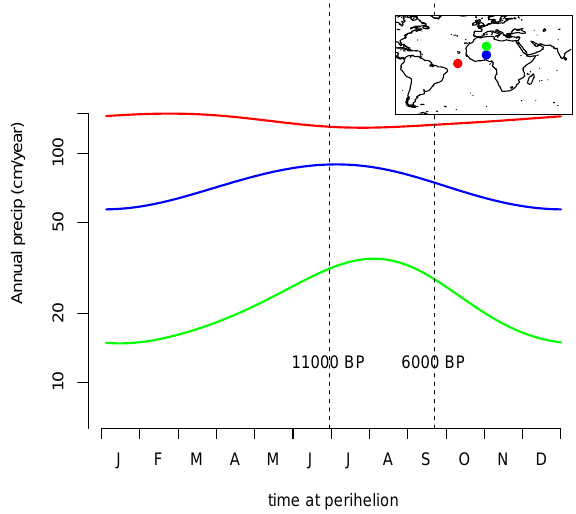
Figure 9. Emulated annual precipitation for three locations at the North Atlantic/African sector as a function of the longitude of the perihelion. For ease of interpretation, the longitude of the perihelion is denoted as the time of the year at which perihelion (closest point to the Sun) is